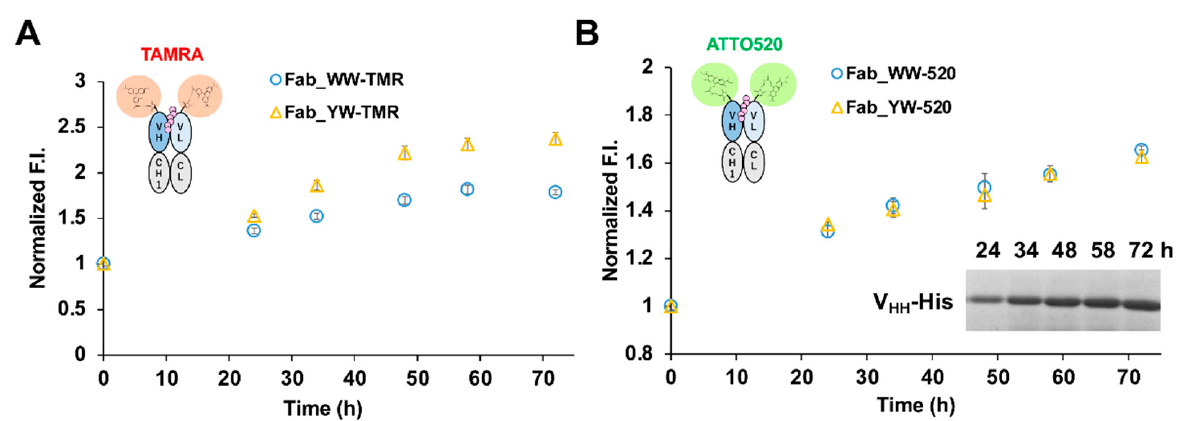
Figure 6. Responses of Q-bodies to His-tagged protein. His 6 -tagged V HH secreted by the transformed Brevibacillus in M9 culture was detected by TAMRA- ( A ) and ATTO520-( B ) labeled Fab-type Q-bodies in 50% M9 culture medium. Error bars indicate ± 1 SD (n = 3). Inset: CBB stained gel of V HH -His protein in the culture medium at indicated time points. To verify the relationship between the fluorescence signal displayed by the Q-body and the concentration of V HH -His in a 50% M9 culture medium, we made correlation charts using these two data sets and four types of Q-bodies (Figure 7). The high correlation coefficient R 2 (Fab_WW-TAMRA: 0.99; Fab_YW-TAMRA: 1.00; Fab_WW-ATTO520: 0.99; Fab_YW-ATTO520: 0.98) indicated that the fluorescence signal displayed by the